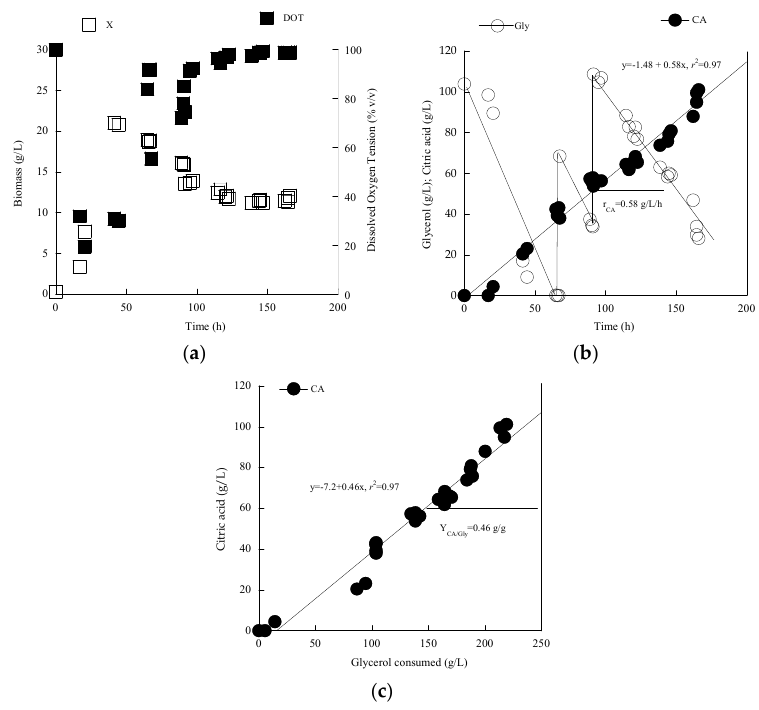
Figure 4. Kinetics of dry yeast cell mass evolution ( X , g/L) and dissolved oxygen tension (%, v/v ) vs. time ( a ), glycerol evolution ( Gly , g/L) and citric acid production ( CA , g/L) vs. time ( b ), and citric acid produced ( CA , g/L) vs. glycerol consumed (g/L) ( c ) by Yarrowia lipolytica LMBF Y-46, during growth on pure glycerol in pulsed fed-batch bioreactor experiments under nitrogen-limited conditions. Culture conditions as in Table 3. Each experimental point is the mean value of two independent determinations (SE ≤ Table 4. Metrics of production of citric acid by yeasts belonging to the species Yarrowia ( Candida—Saccharomycopsis—Endomycopsis) lipolytica, during growth on various substrates in bioreactor experiments. Comparisons with the current study.